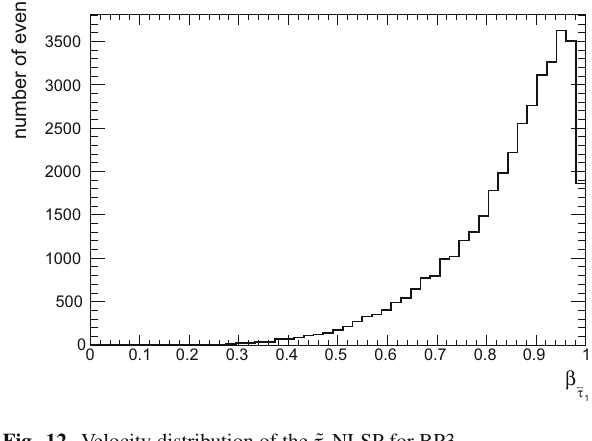
Fig. 12 Velocity distribution of the ˜ τ -NLSP for BP3